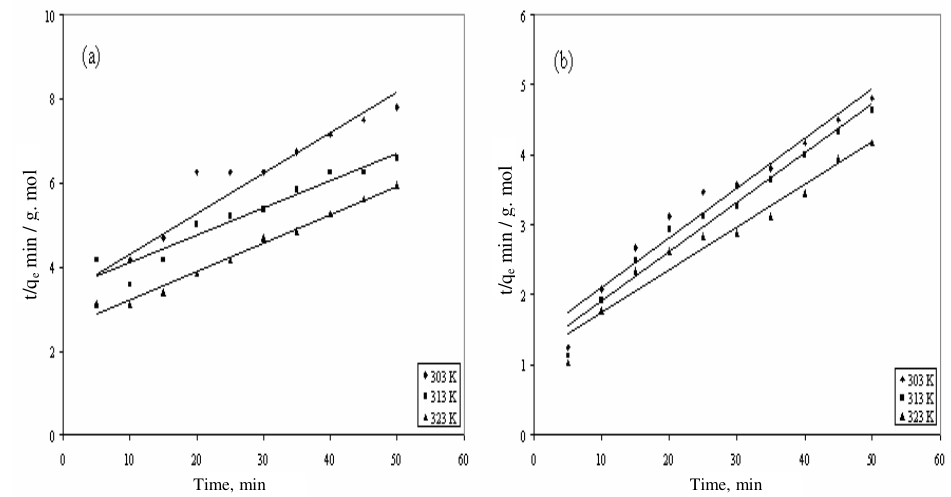
Figure 6 . Pseudo-second-order kinetics plots for the sorption of Ni 2+ ions from aqueous solutions onto (a) Na-ZSM-5 (b) PNa